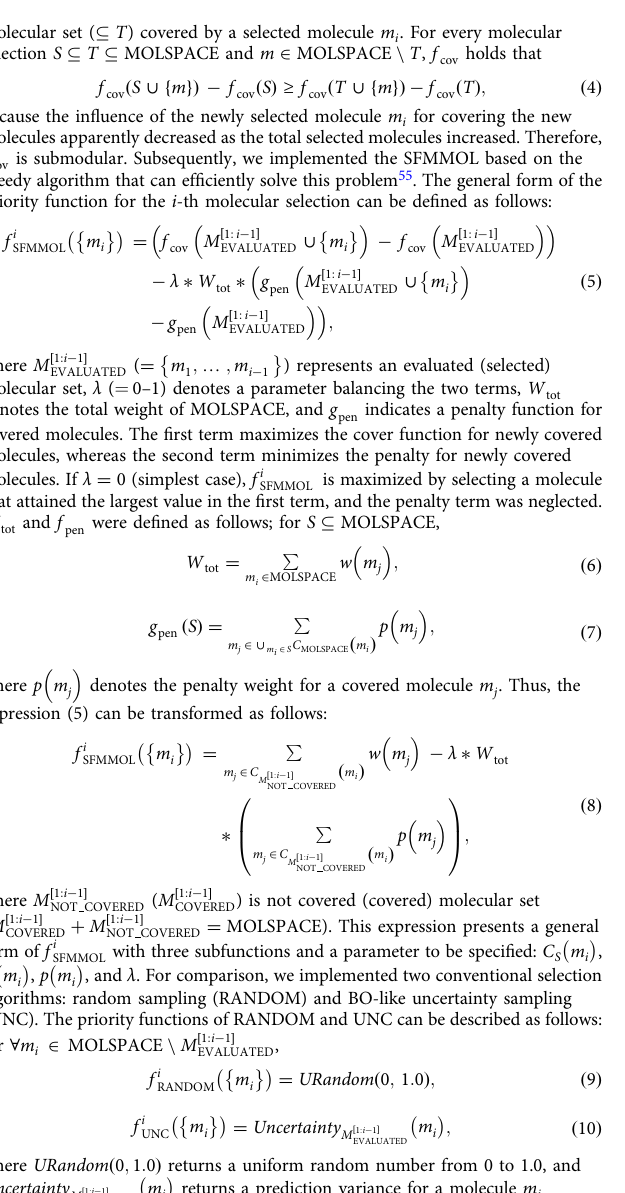
Fig. 8 UV – Vis absorption spectra of 7 in mixed solvents of S5 (methanol) and S11 (tetrahydrofuran). a change of the spectra of 7 along with the mixing ratio of solvents b spectra characteristics ( λ max , Intensity, FWHM, and Area) considered from major peaks using the method explained in the following